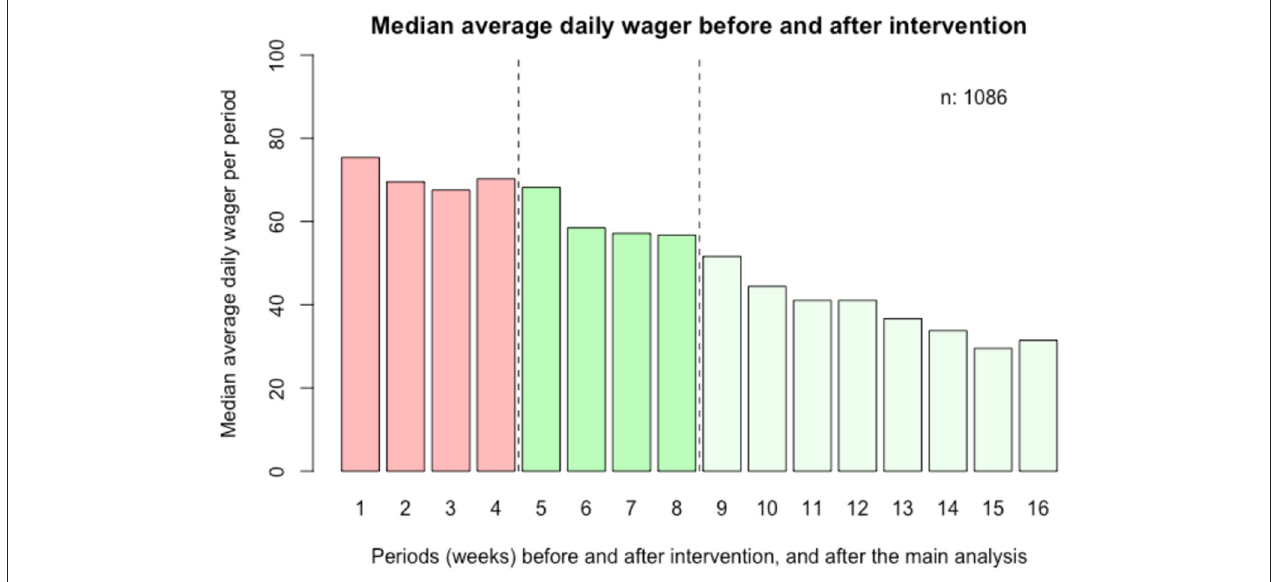
FIGURE 4 | Secondary analysis; average daily log wager before (28 days) and after (84 days) intervention. Weeks before (weeks 1–4) and after (weeks 5–16) the